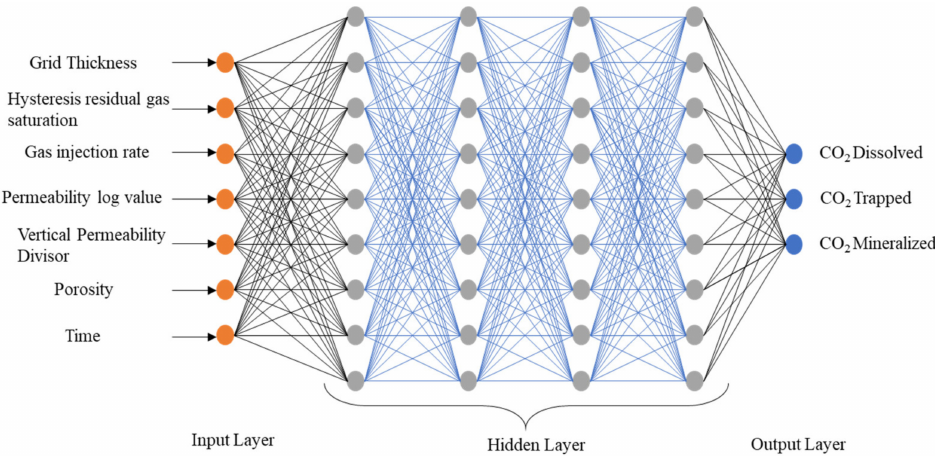
Figure 3. Architecture of the proposed MLP model. Table 2. Parameters used for training the machine learning